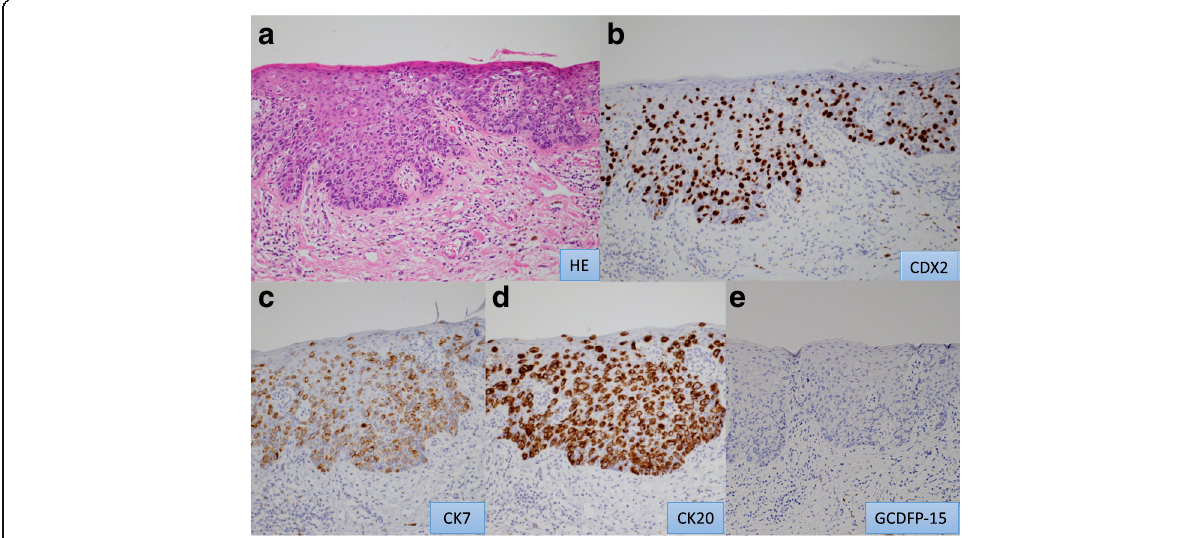
Fig. 4 Histological findings of perianal Paget ’ s disease. a Paget ’ s cells with clear cytoplasm and large pleomorphic nuclei (hematoxylin-eosin; magnification × 20). b – d Positive immunohistochemical staining for cytokeratin (CK) 7 ( b ), CK20 ( c ), and caudal-related homeobox gene